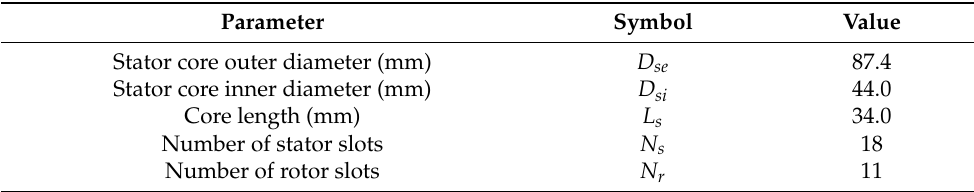
Table 1. The design data for the investigated induction